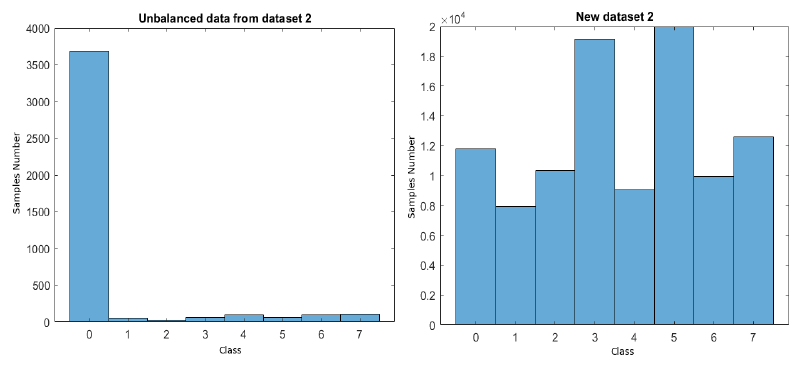
Figure 6. SWAT dataset distribution.